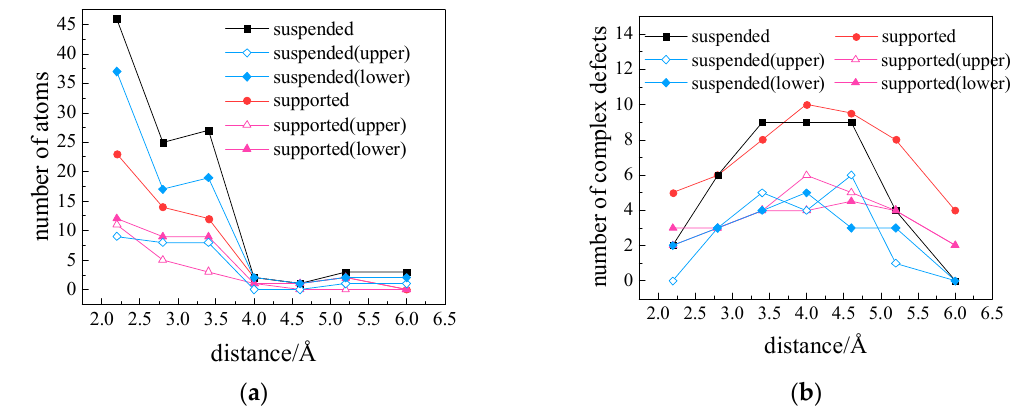
Figure 7. The relationship between defect and irradiation density of suspended and supported bi- layer graphene (BLG) (irradiation energy of 4.41 keV; irradiation dose of 25): ( a ) number of knock-on atoms; ( b ) number of complex defects.